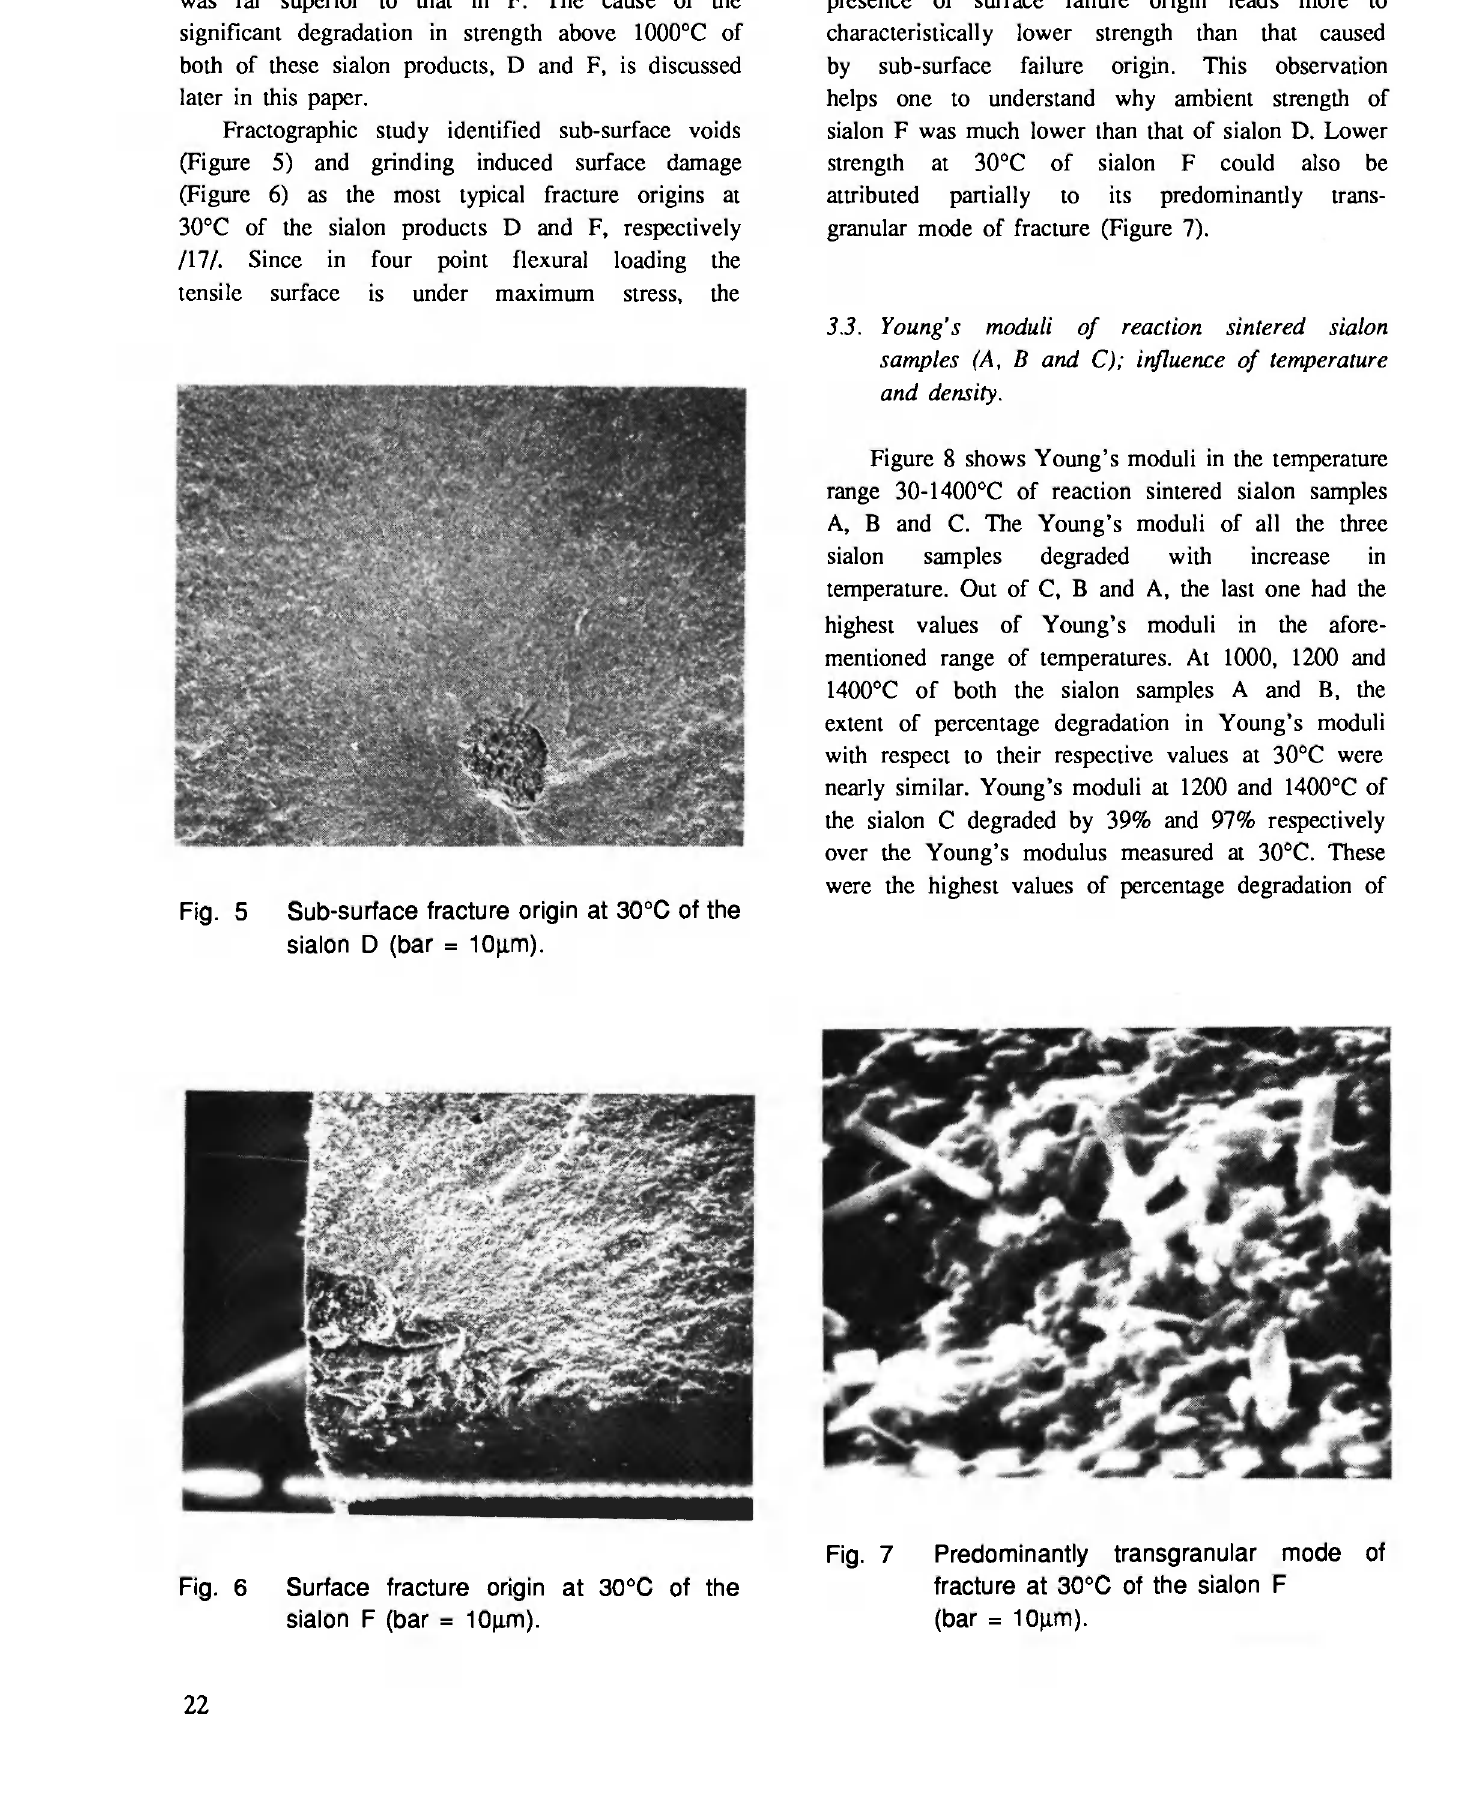
Fig. 5 Sub-surface fracture origin at 30°C of the sialon D (bar = 10μσι).